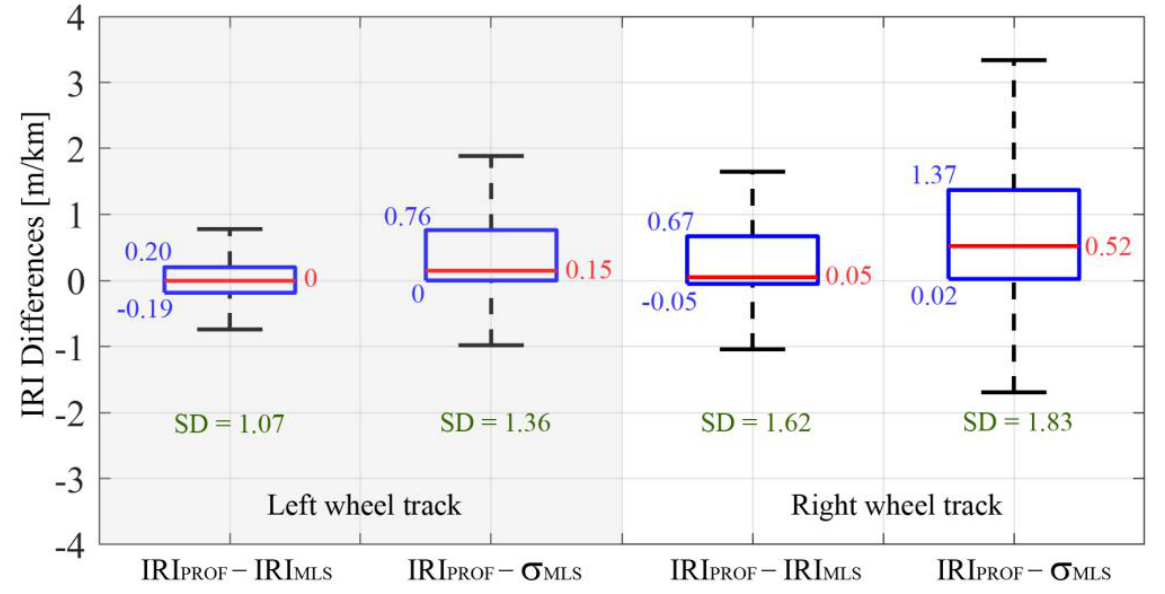
Figure 5. Box plots of the International Roughness Index (IRI) differences.